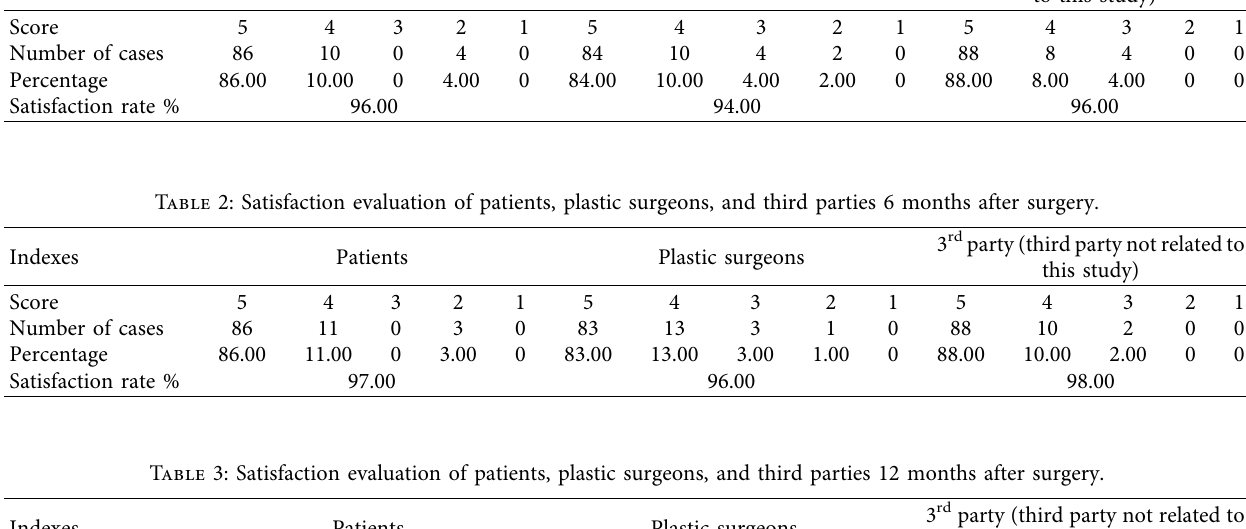
Table 1: Satisfaction evaluation of patients, plastic surgeons, and third parties on the 7 th day after the operation. Indexes